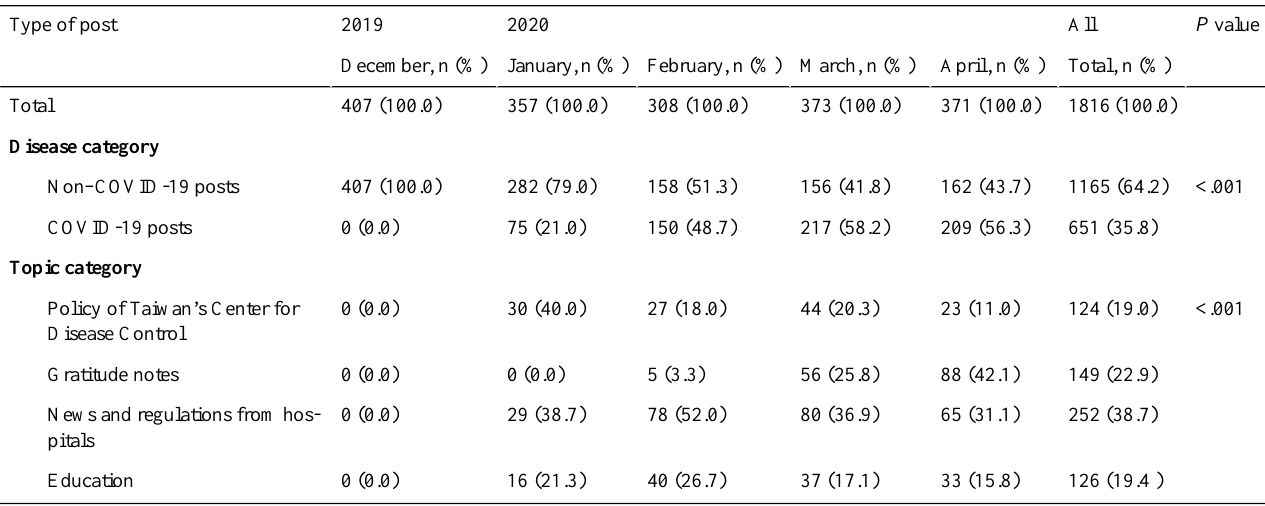
Table 2. COVID-19 and non–COVID-19 Facebook posts of nationwide medical centers from December 2019 to April